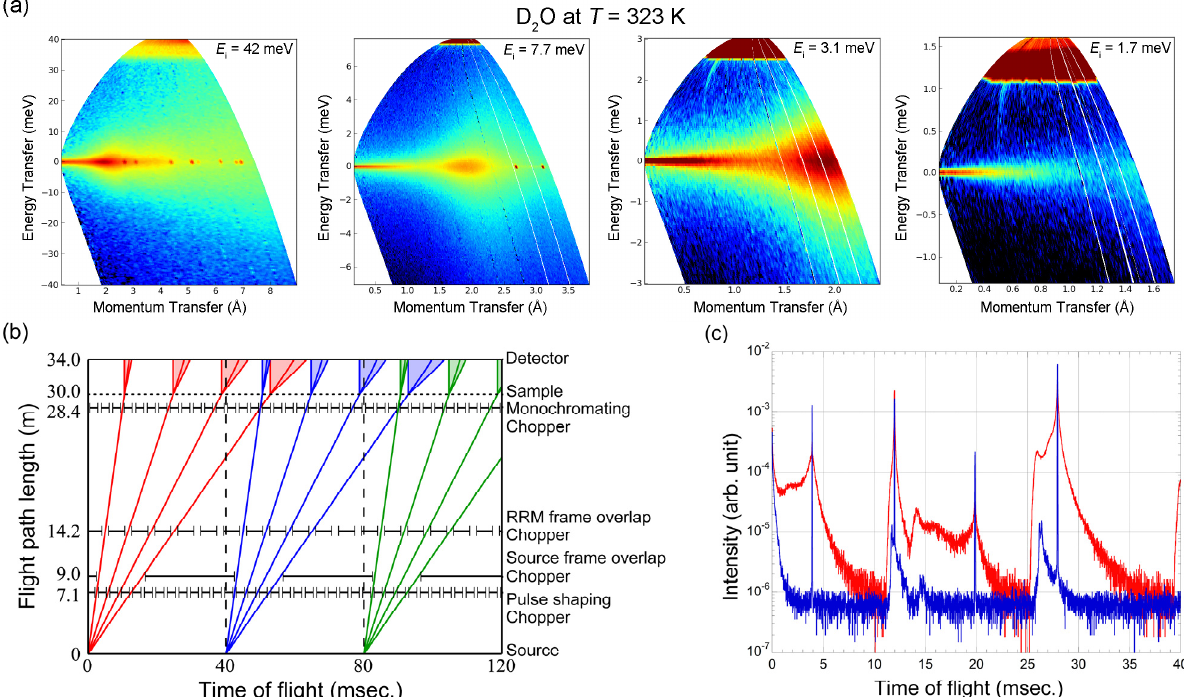
Fig. 2. An actual use of the interveined trajectory in AMATERAS at J-PARC, where we could realize the measurements with four E i s—42, 7.7, 3.1, and 1.7 meV—and energy resolutions in the 0.9 – 0.01 meV range, which corresponds to 0.02 ps−500 ps time windows. (a) Example of data obtained from D 2 O measurements at 323 K . (b) Time-of-flight (TOF) diagram of this condition ( E i s from the T < 0 are omitted in the figure). (c) TOF spectrum measured of D 2 O data shown in (a) (red line) together with a vanadium cylinder at room temperature data (blue line). The data obtained at the equatorial position detector pixels were used. Note that AMATERAS has another band chopper at 13.7 m position, which is not used in this condition, and is therefore removed in panel (b). It should be noted that the value of the flight path length from the source to the detector shown in panel (b) is at the equatorial position of the detector bank [4]. Actual distance from the sample to the detector pixels spreads from 4 m to 4.4 m.